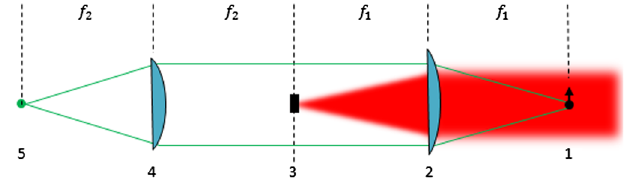
FIG. 4 (color online). Optical schematics for a bench test designed to take images of the wire in motion. (1) moving wire illuminated by a pulsed diode laser; (2) first Fourier transform lens, (3) spatial filter that removes the zero order laser light; (4) second Fourier transform lens; (5) image of the moving wire formed by the scattered laser light, observed with a CCD camera (not shown).